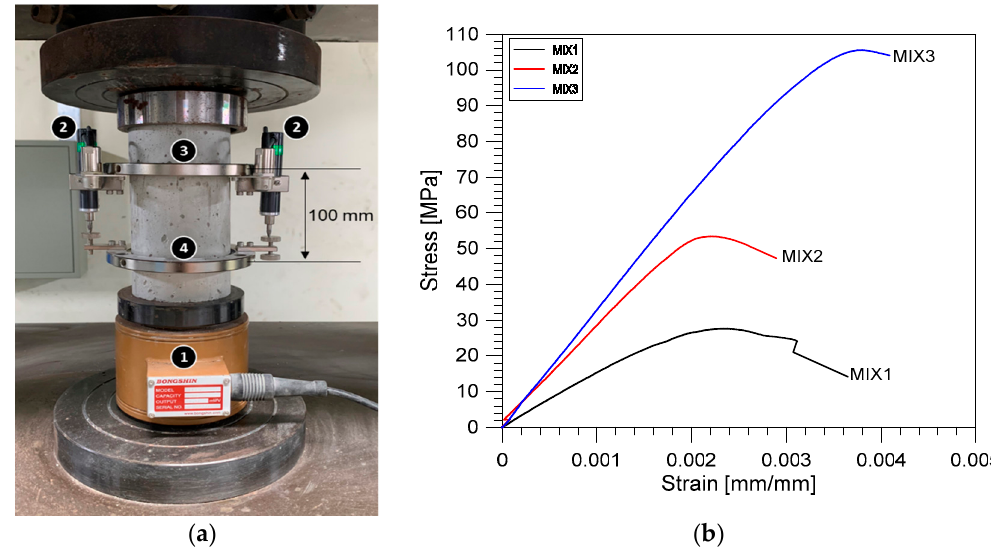
Figure 8. ( a ) Test setup for the uniaxial compressive test for measurements of compressive strength and static modulus of elasticity of concrete cylinders and ( b ) typical stress and strain relations calculated from the concrete cylinders with MIX 1, 2, and 3 in the fully dry conditions (oven-dry (OD)).